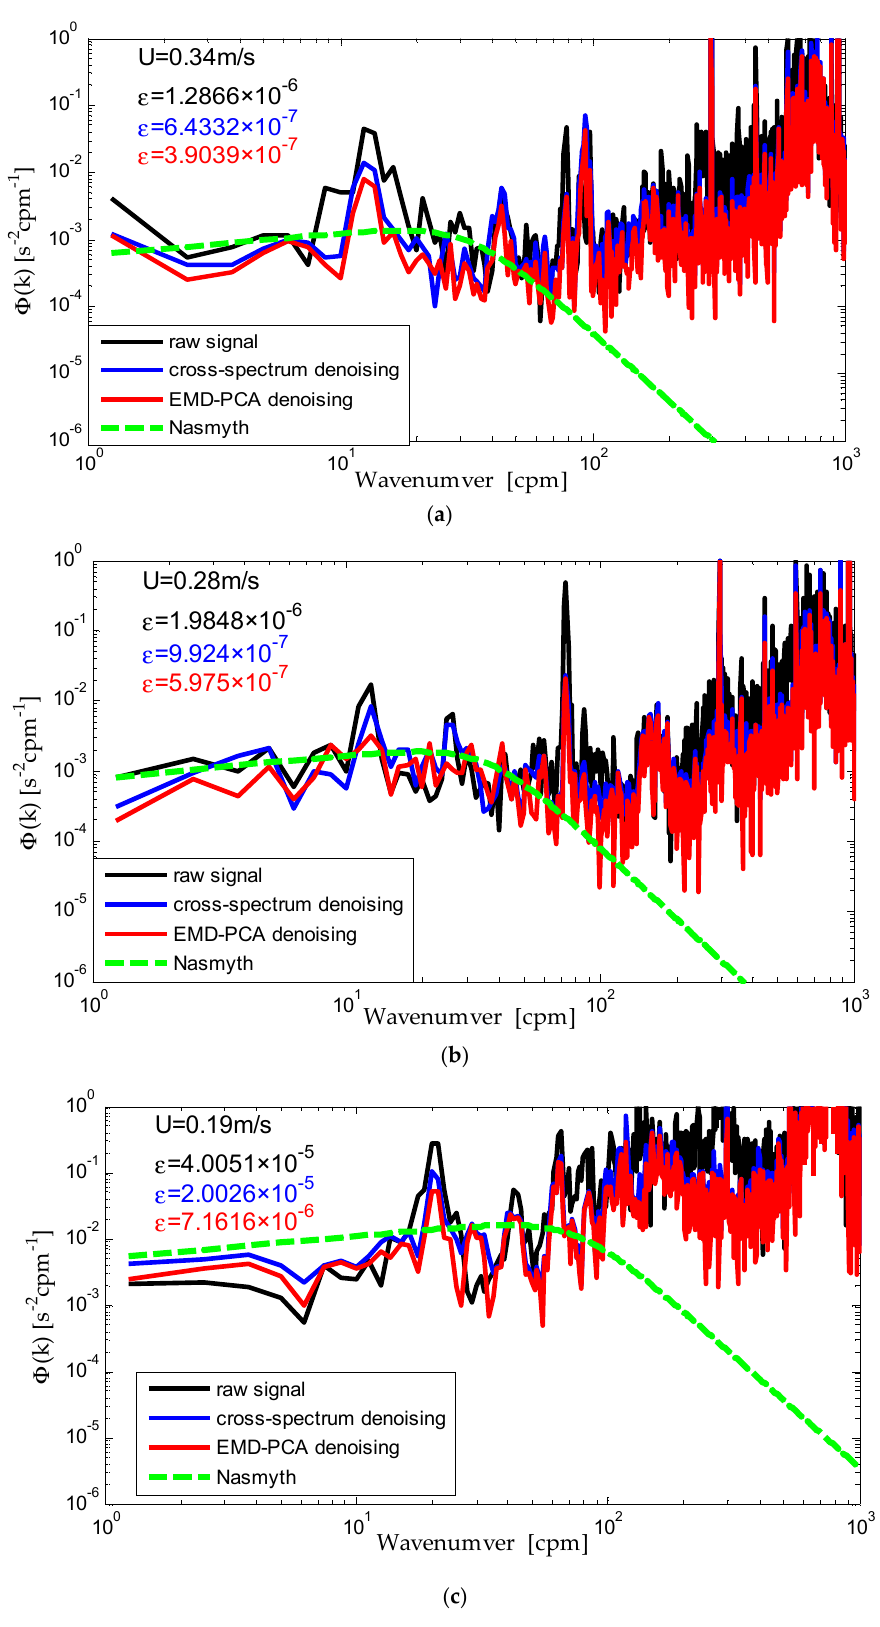
Figure 6. Comparison of denoising effectiveness. ( a ) The corresponding current speed is 0.34 m/s; ( b ) the corresponding current speed is 0.28 m/s; ( c ) the corresponding current speed is 0.19 m/s.